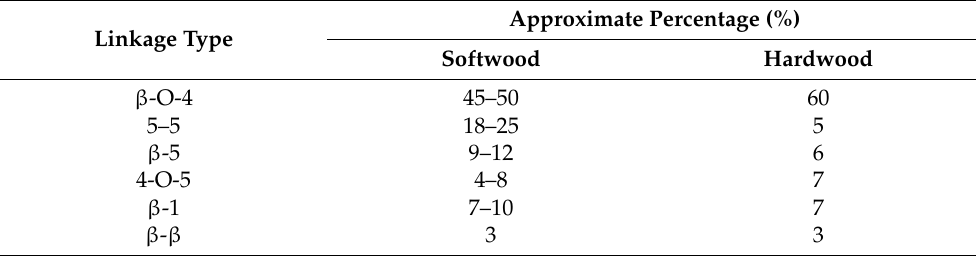
Table 2. Approximate percentages of linkages found in softwood and hardwood lignin